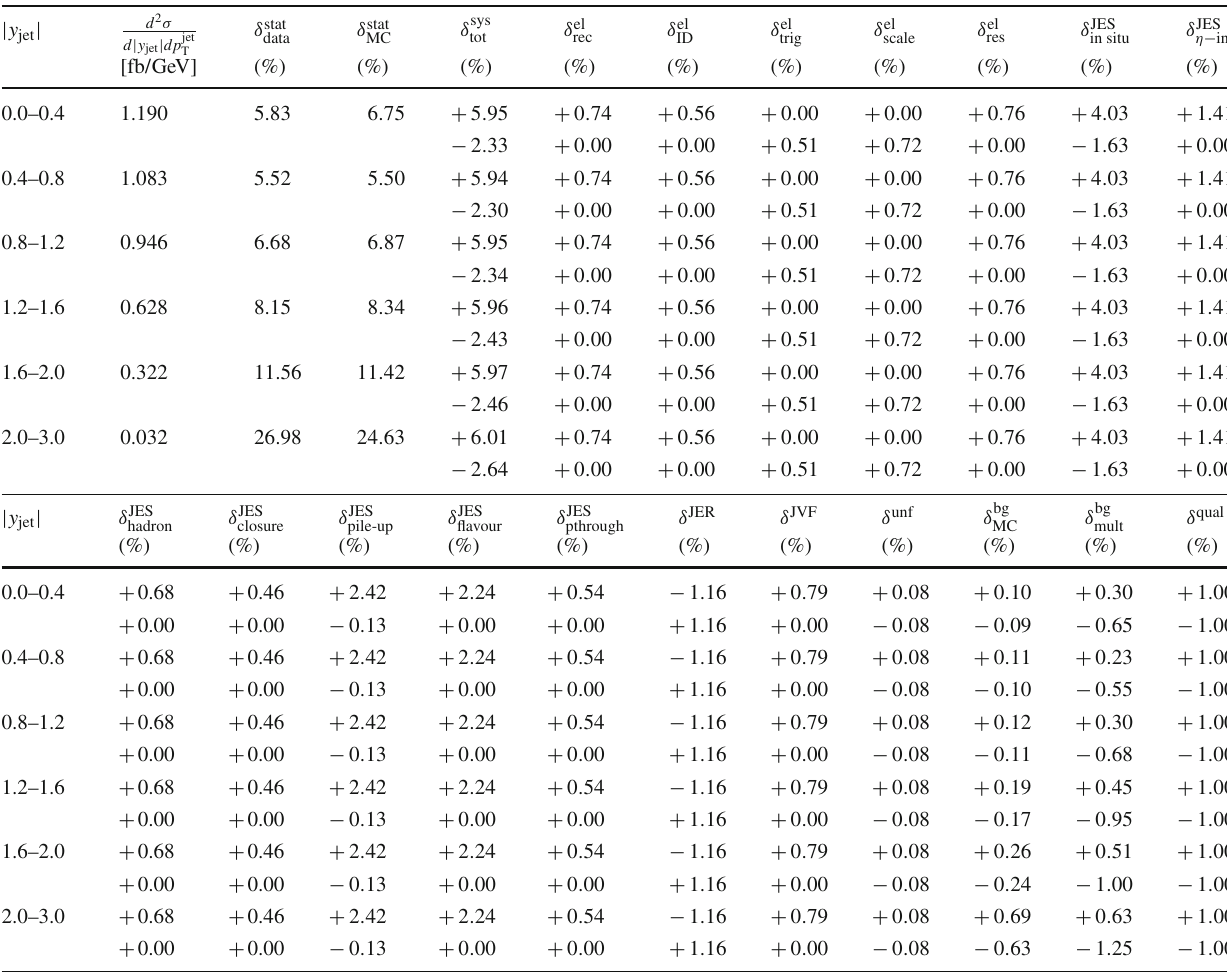
Table 7 The measured double-differential Z + jets production cross- < 400GeV range. sections as a function of | y jet | in the 300GeV < p jet T δ stat and δ stat are the statistical uncertainties in data and MC simulation, data MC respectively. δ sys tot is the total systematic uncertainty and includes the fol- lowing components: uncertainties due to electron reconstruction ( δ el rec ), identification ( δ el ) and trigger ( δ el ) efficiencies; electron energy scale ID trig ( δ el ) and energy resolution ( δ el res ) uncertainties; sum in quadrature scale of the uncertainties from JES in situ methods ( δ JES ); sum in quadra- in situ ture of the uncertainties from JES η -intercalibration methods ( δ JES η ); an -int uncertainty of the measured single-hadron response ( δ JES ); MC non- hadron closure uncertainty ( δ JES ); sum in quadrature of the uncertainties closure